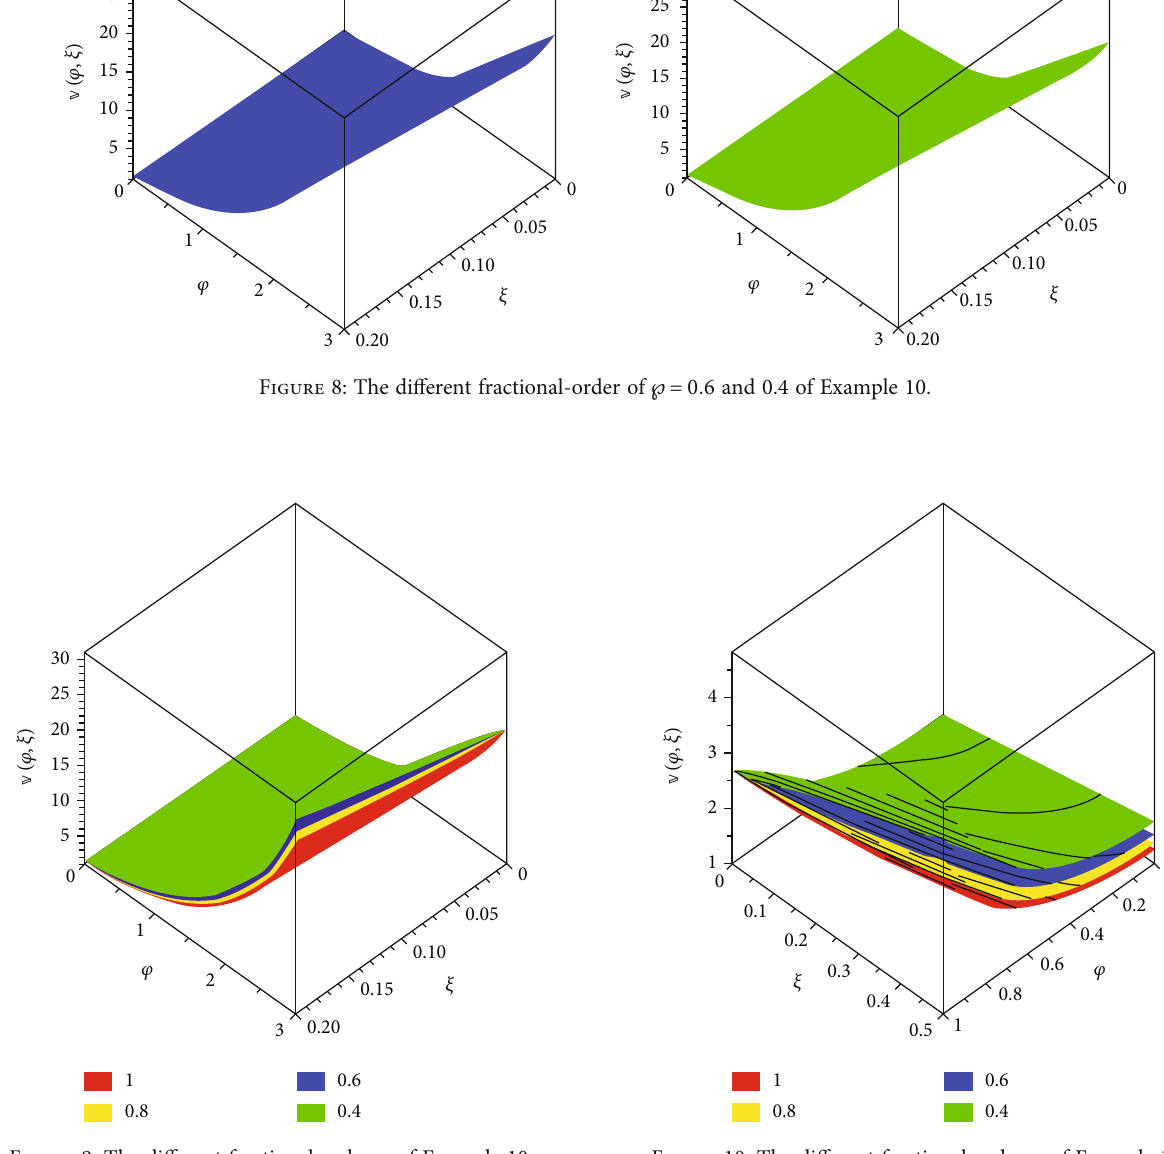
Figure 9: The di ff erent fractional-order ℘ of Example 10. Figure 10: The di ff erent fractional-order ℘ of Example 13.